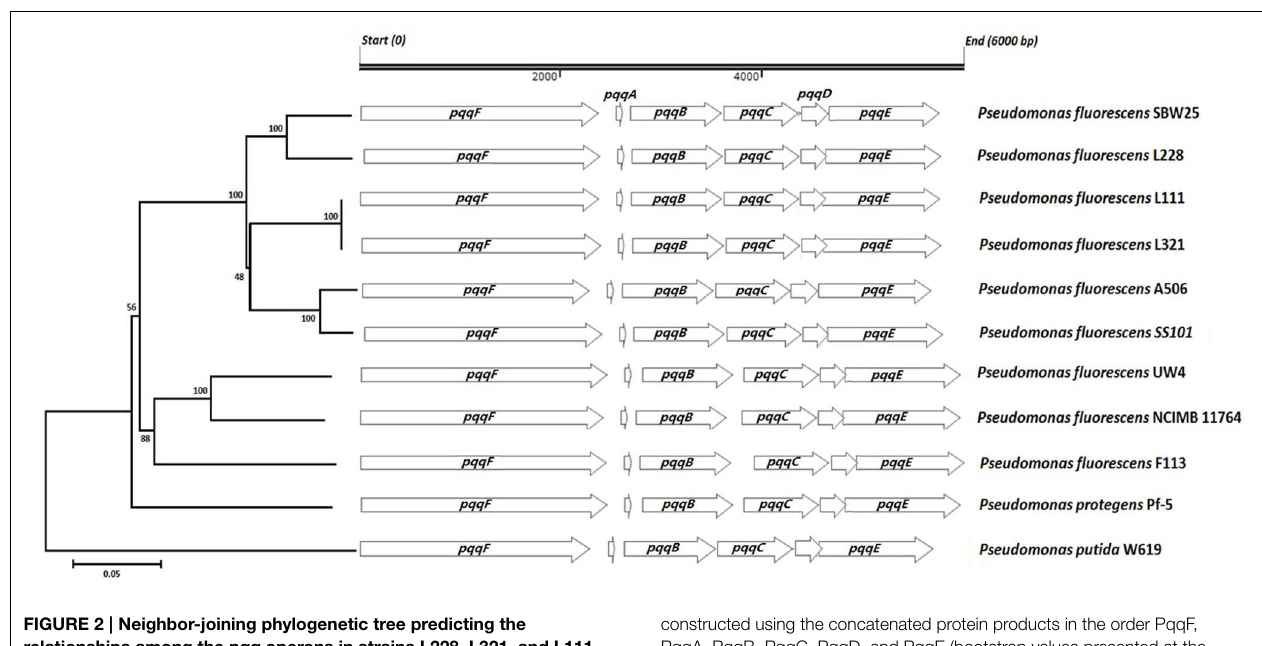
FIGURE 2 | Neighbor-joining phylogenetic tree predicting the relationships among the pqq operons in strains L228, L321, and L111 with those of published Pseudomonas genomes. The tree was